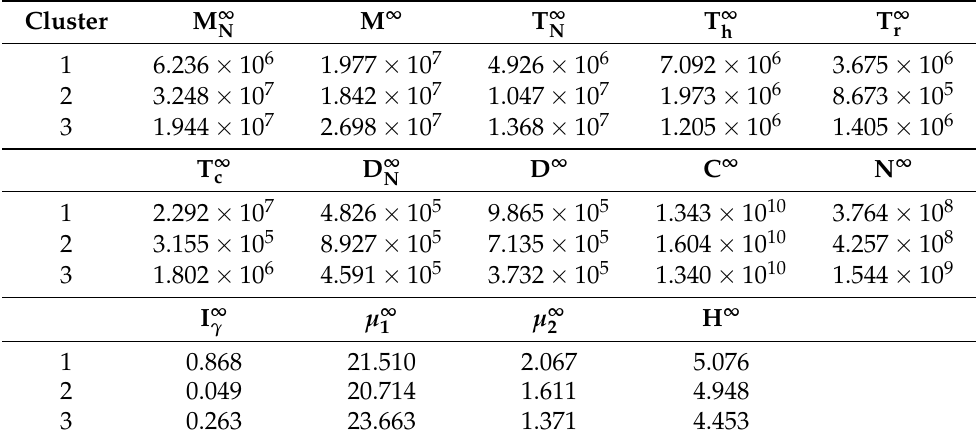
Table 2. Steady-state abundance of cells and